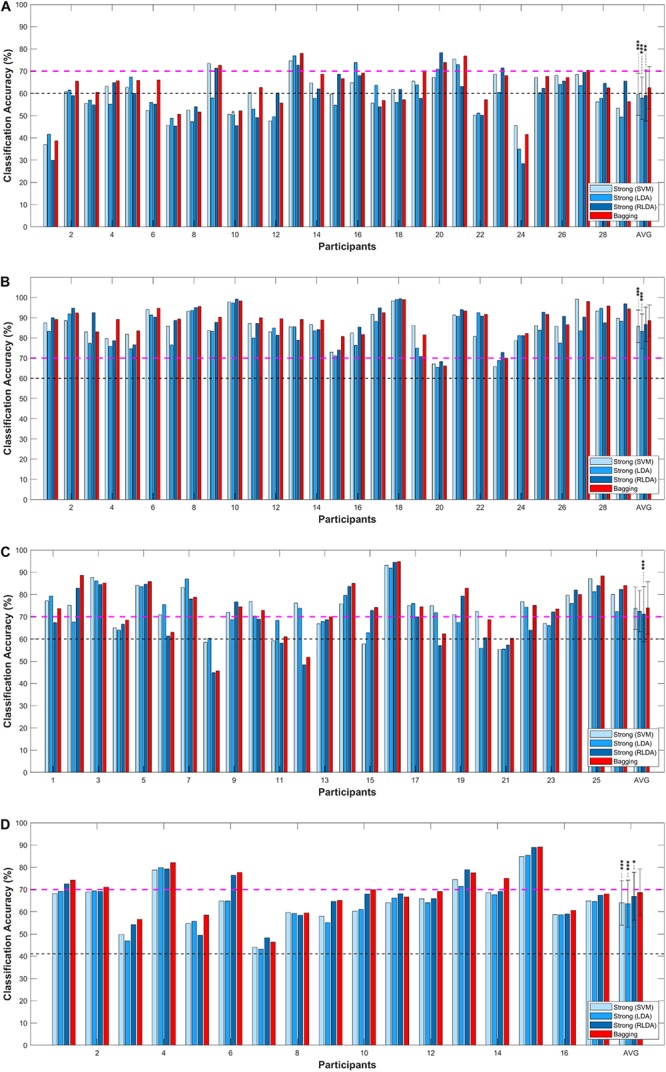
Comparisons of individual accstrong (blue) and accbag (red) for (A) dataset I, (B) dataset II, (C) dataset III, and (D) dataset IV. The error-bar indicates the standard deviation. The magenta dashed line represents the effective BCI threshold level (70.0%) indicating (Vidaurre and Blankertz, 2010). AVG represents the average of the classification accuracies across all participants. ∗Corrected-p < 0.05, ∗∗corrected-p < 0.01, and ∗∗∗corrected-p < 0.001 (false discovery rate correction).